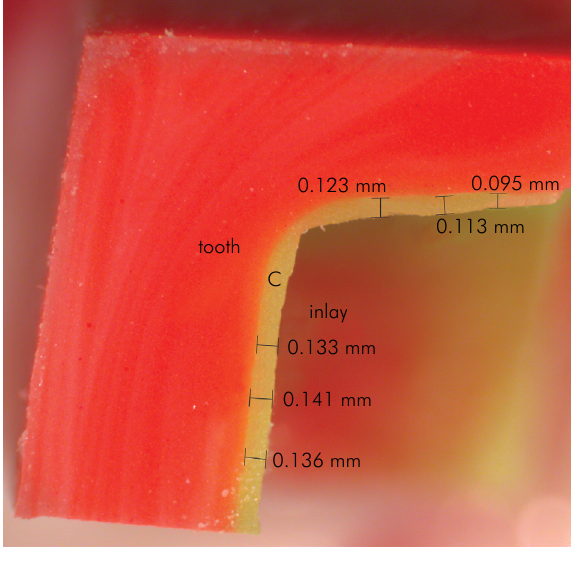
Figure 3. Measurement of internal adaptation: three points were used from axial walls and three points from the pulpal floor of the replicas (C, cement